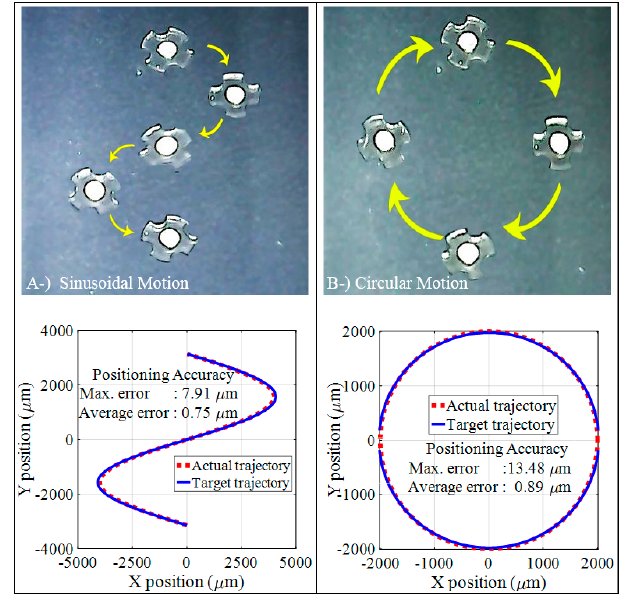
Figure 13. The sinusoidal and circular orbit trajectories have been successfully tracked. ( A ) shows the sinusoidal trajectory followed by the signal input given as amplitude 4 mm. In ( B ), a circular orbit with a radius of 2 mm was followed.